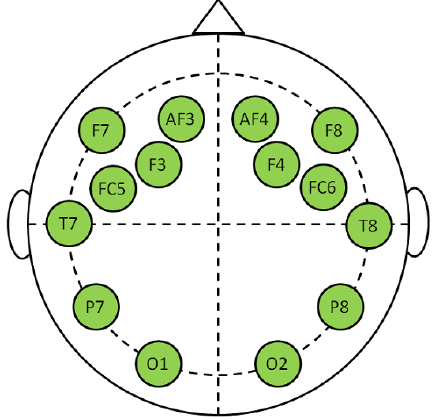
Figure 1. Image X Emotiv EPOC headset—10–20 system.